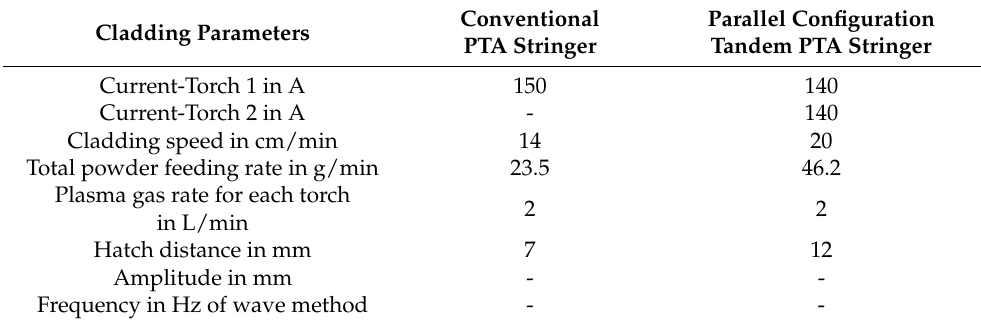
Table 3. Cladding Parameters of the conventional PTA and Tandem PTA for coating.